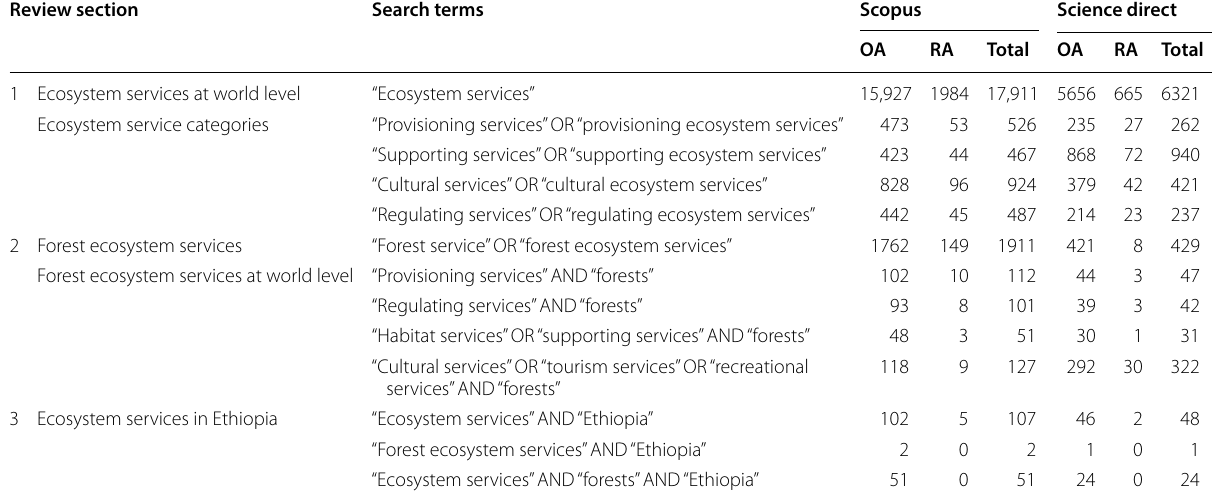
Table 1 The number of publications on ecosystem and forest ecosystem services using Scopus and science